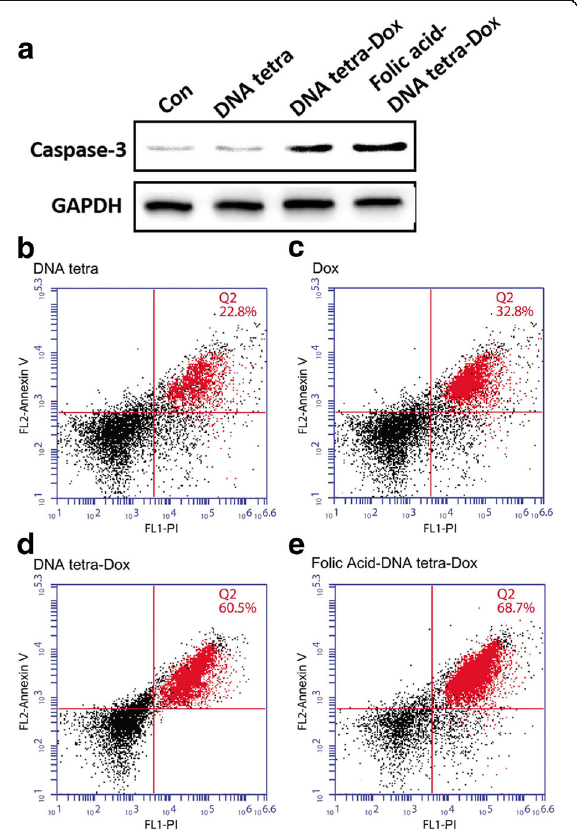
Fig. 5 The cellular expression of apoptosis-related caspase-3 after being treated with different complexes ( a ) and the flow cytometry of HT-29 cells after being incubated with DNA tetra, Dox, DNA tetra-Dox, and folic acid-DNA tetra-Dox ( b – e )